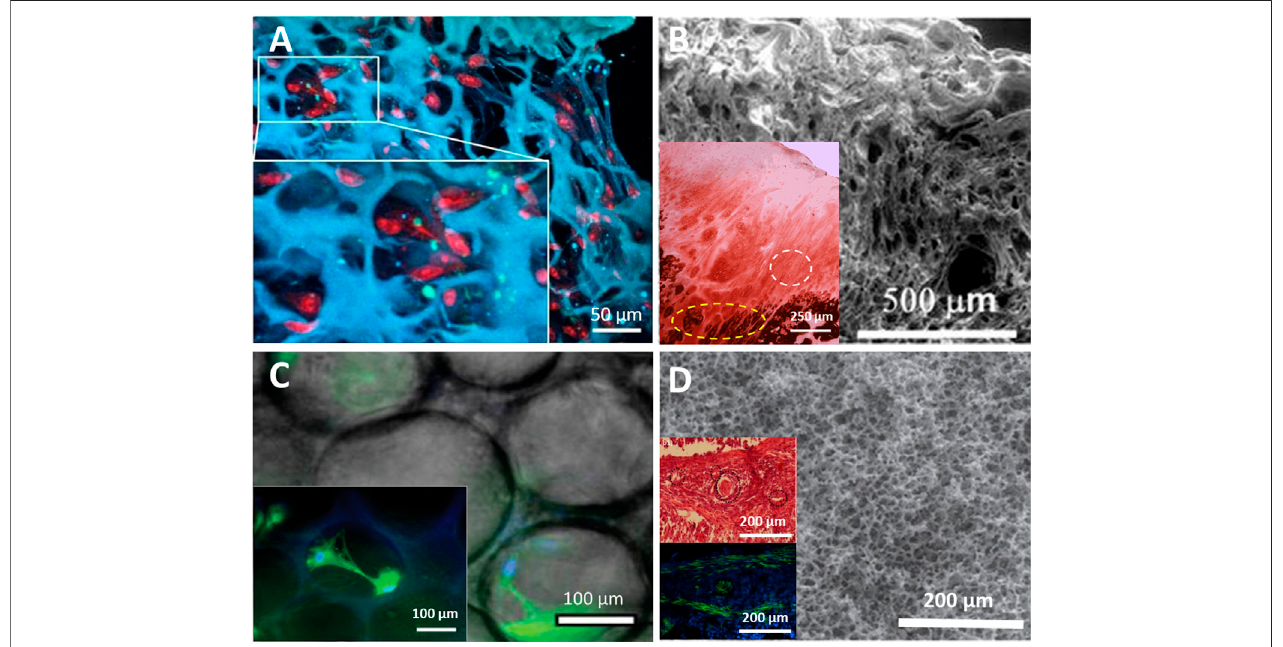
FIGURE 4 | Cell interactions with porous scaffolds: (A) ELR scaffold hydrogel produced by gas foaming with proliferation of SMCs (cross section reproduced with permission from Fernández-Colino et al. (2018). (B) Physically cross-linked ELR porous scaffold showing complete articular cartilage regeneration (white dotted line in inset)andareasofossi fi cation(yellowdottedlineininset) invivo (SEMandhistologicalresultsreproducedwithpermissionfromPescadoretal.(2017),copyrightSpringer Nature, 2017). (C) ELR porous scaffold produced with physical interactions, showing good cell viability with hMSCs growing within pores (inset) (micrographs reproducedwithpermissionfromIbáñez-Fonsecaetal.(2020a),copyright2020,JohnWileyandSons); (D) Clickchemistrycross-linkedELRporousscaffoldcontaining enzyme-labile sequences, supported the development of robust blood vessels as it degraded in a reciprocal manner (SEM, histochemical (top) and immunohistochemical (bottom) images (insets) reproduced with permission from Flora et al. (2019b), copyright 2019, Institute of Physics).